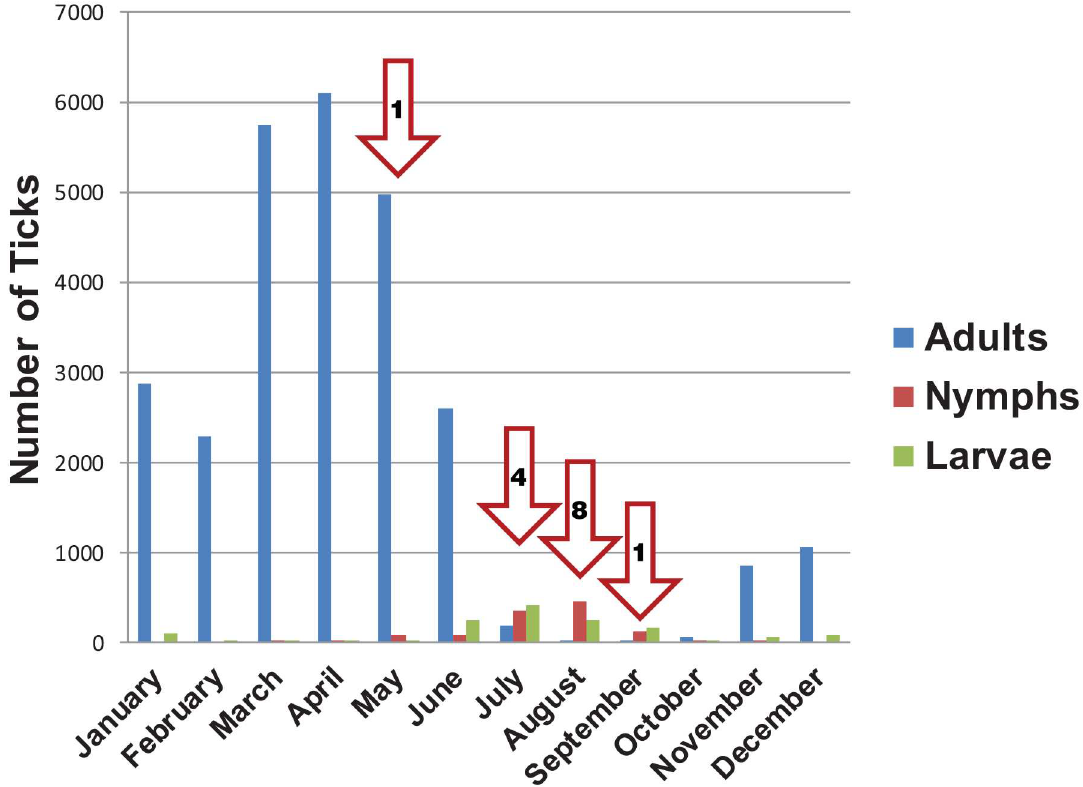
Fig 1. Dermacentor occidentalis collection records in California by month; adults were collected from 1948–2014, nymphs 1949–2014, and larvae 1969–2014. Red Arrows indicate illness onset month for human cases of Pacific Coast tick fever (numbers inside arrows represent onset of symptoms for human cases per